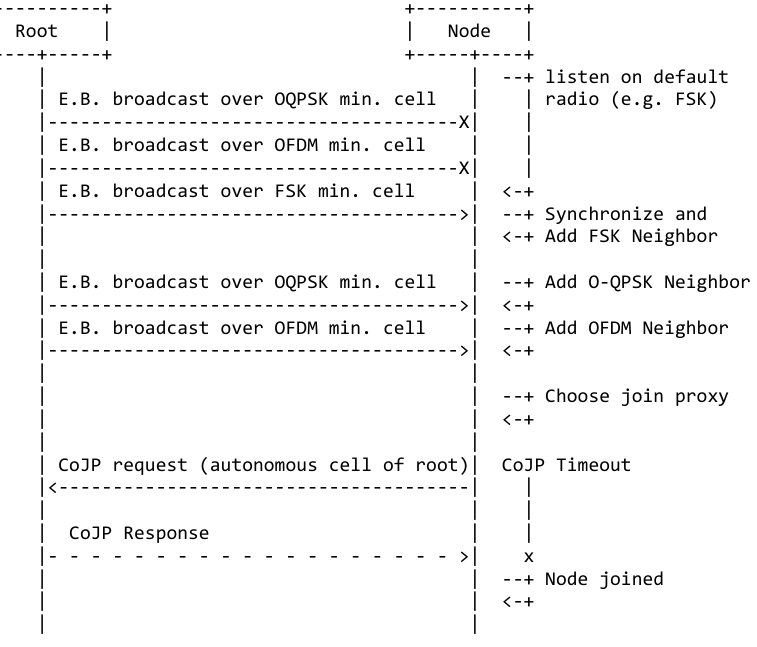
Figure 5. Synchronization and join process when using 6DYN. The 6top Protocol (6P) is used by neighbor nodes to negotiate when adding/deleting cells with one another [12]. The second change is to extend 6P for an ADD request to indicate which PHY to use. We use the left-most 3 bits of the Cell Options byte in the 6P header to encode the PHY index of the requested cells. These bits are currently “reserved for future use” in the 6P standard. The resulting 6P ADD transaction is illustrated in Figure 6.